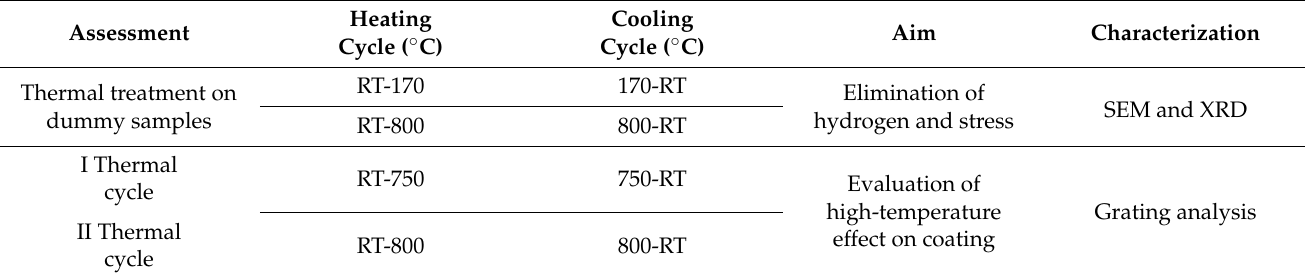
Table 1. Operative conditions used during thermal treatment and thermal